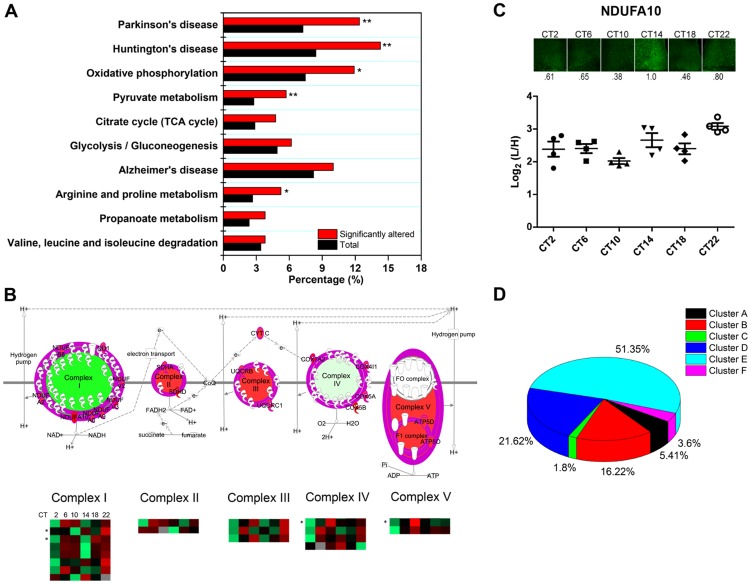
Mitochondrial oxidative phosphorylation represents a major axis of regulation within the SCN.(A) KEGG pathway enrichment analysis (by DAVID) of the time-of-day proteome. Pathways that are significantly enriched relative to the SCN proteome (2112 proteins) are denoted with an asterisk. *p<0.05, and **p<0.01 (Fisher's exact test). (B) Schematic representation of the 19 rhythmic proteins in our proteomic dataset that are involved in oxidative phosphorylation, based on IPA canonical pathway analysis. The asterisk (*) denotes four 24-h rhythmic proteins including NDUFA10, NDUFA2, COX4I1, and ATP5D. (C) Immunofluorescent (top) and MS (bottom) analysis of NDUFA10 expression in the SCN as a function of CT. IF images were acquired using a 20× objective. Values below each micrograph (top) represent the median relative abundance of NDUFA10 (n = 3 mice per CT). (D) Distribution of the 111 time-of-day-dependent mitochondrial proteins within the six hierarchical protein clusters.